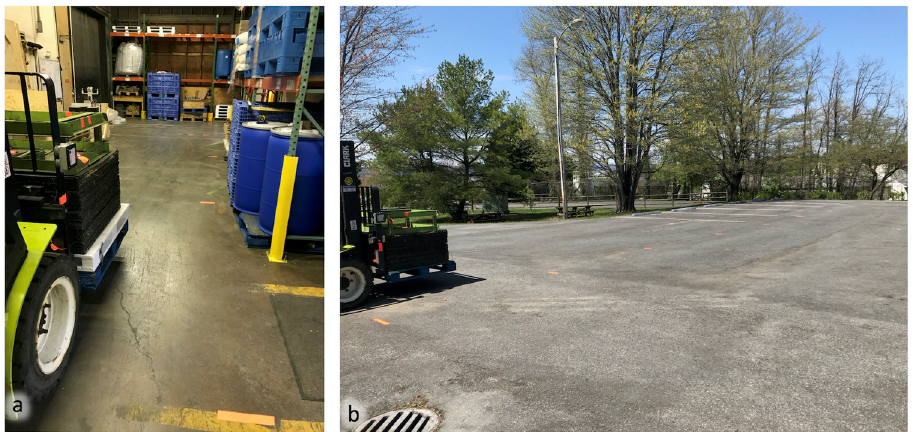
Figure 2. Investigated road conditions: ( a ) concrete, ( b ) asphalt.